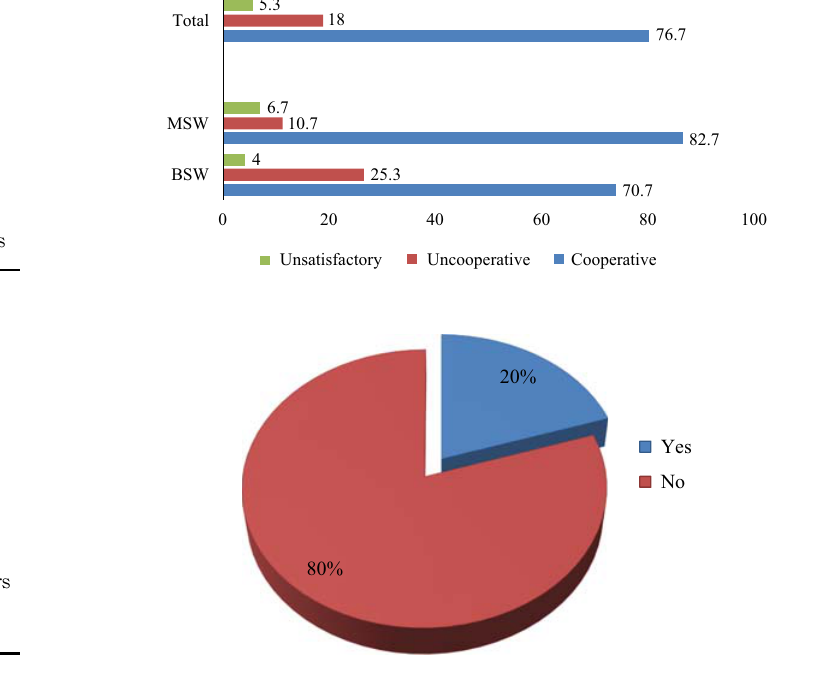
Figure 5. Relationship with